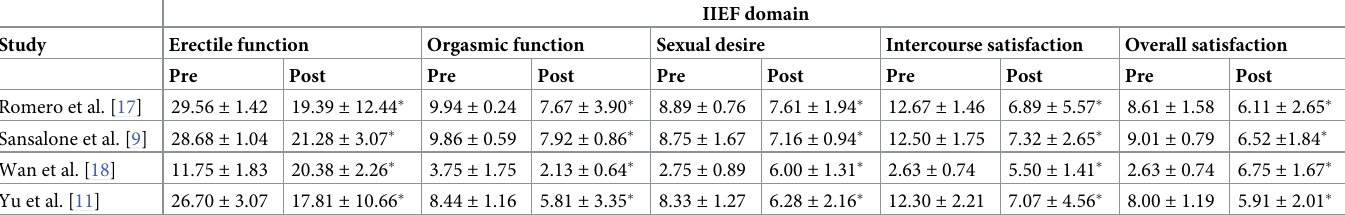
Table 3. Pre- and post-operative measures of sexual function across the included studies as determined by the International Index of Erectile Function (IIEF)